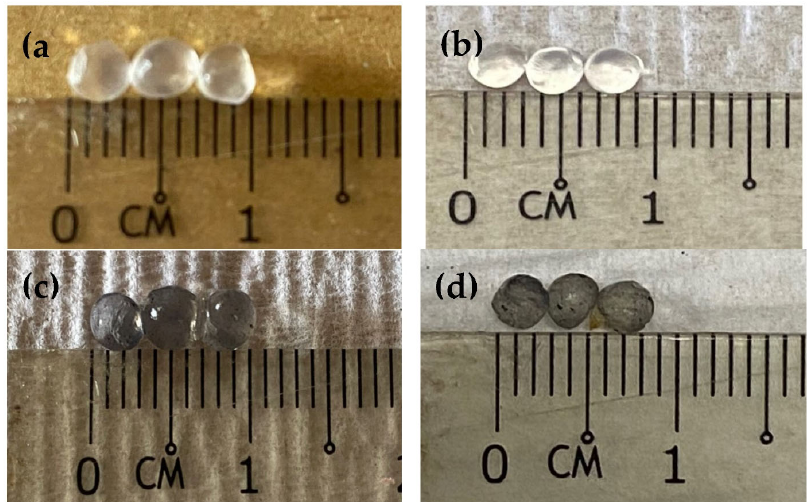
Figure 1 . Physical image of the ( a ) swollen SA −β− CD hydrogel ( b ) air ‐ dried hydrogel SA −β− CD ( c ) Figure 1. Physical image of the ( a ) swollen SA − β − CD hydrogel ( b ) air-dried hydrogel SA − β − CD swollen SA −β− CD/CNTs hydrogel ( d ) air ‐ dried hydrogel SA ‐β‐ CD/CNTs . ( c ) swollen SA − β − CD/CNTs hydrogel ( d ) air-dried hydrogel SA- β